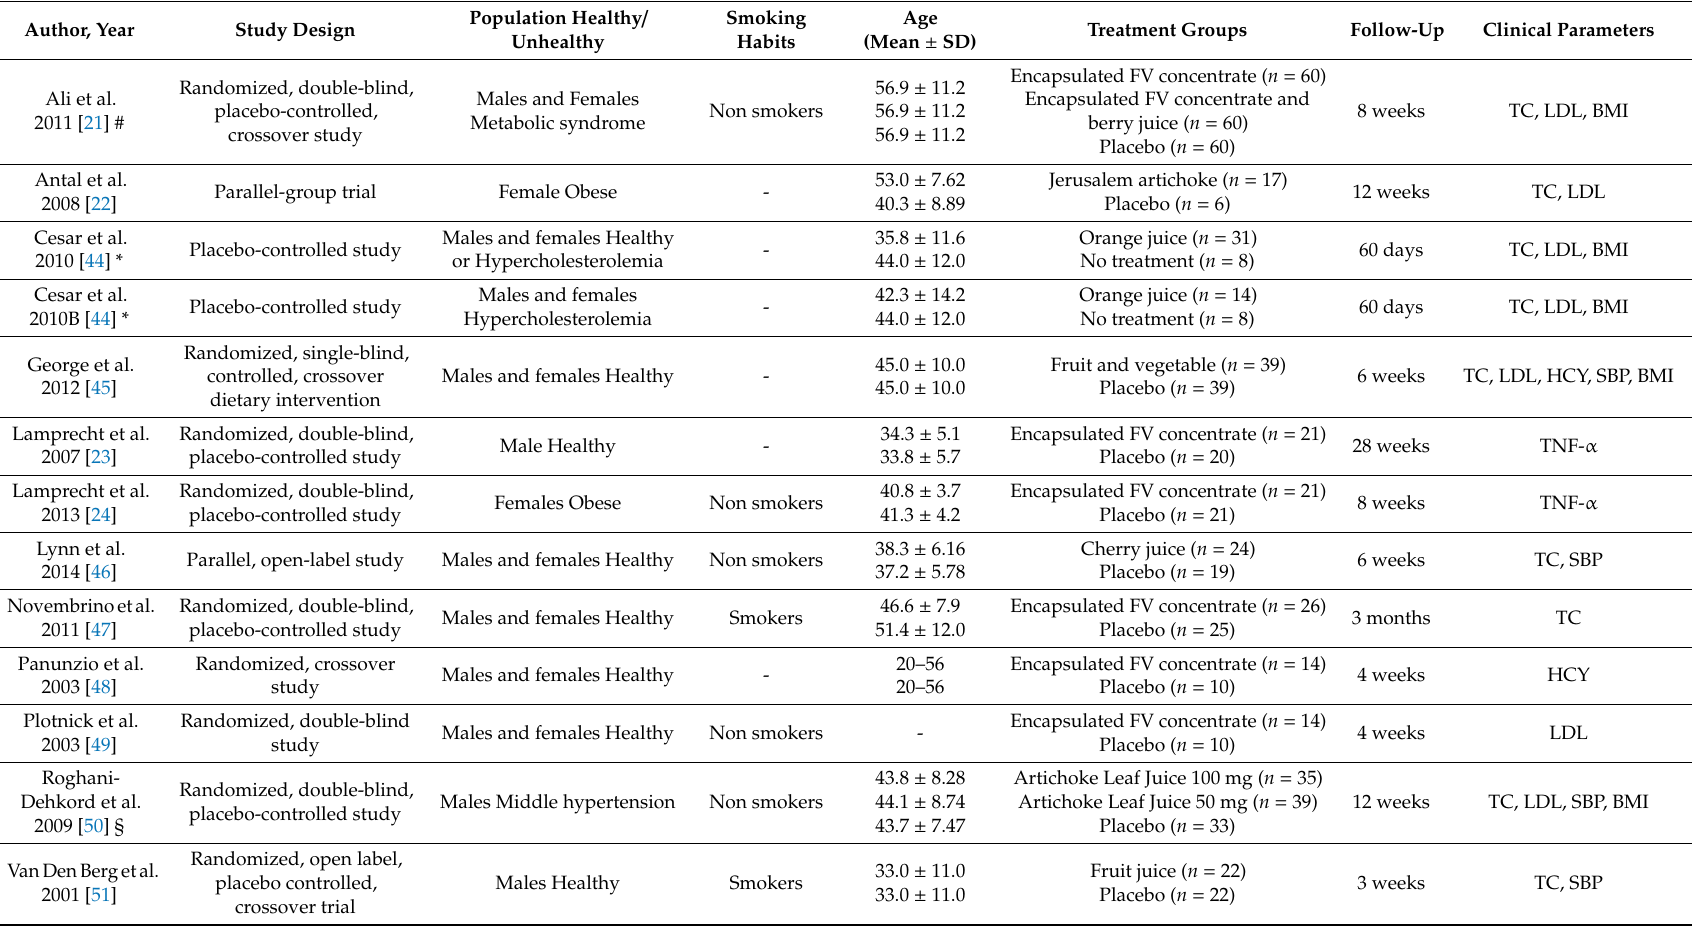
Table 3. Characteristics of the articles that were included in the